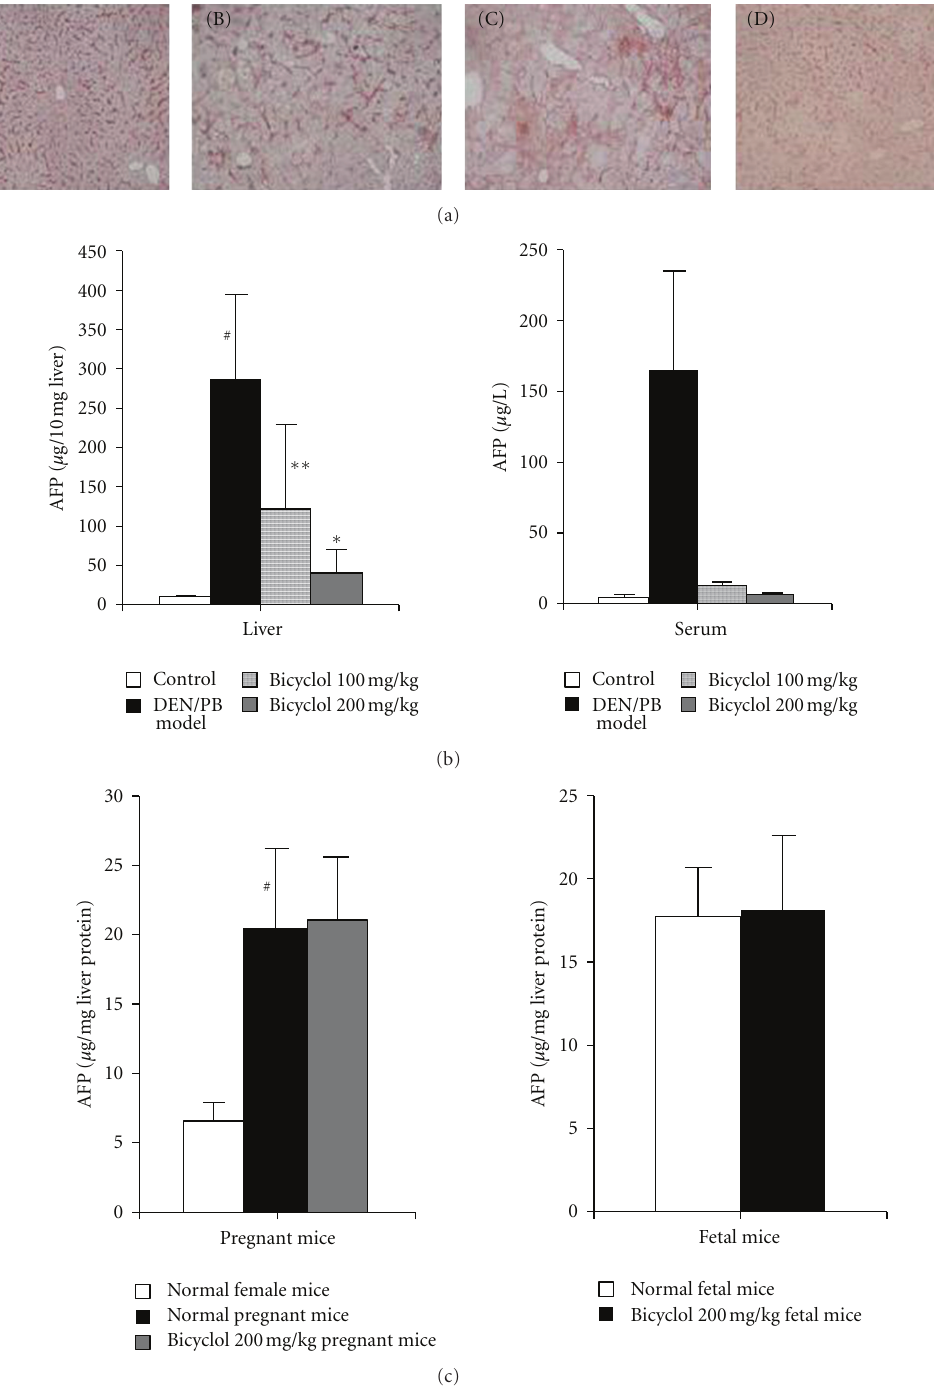
Figure 5: Expression and quantification of α -fetal protein (AFP). (a) AFP-immunoreactivity assay in the control and experimental groups at week 20 using immunohistochemistry assay. (A) control; (B) DEN/PB model; (C) treatment with bicyclol (100mg/kg) before DEN injection; (D) treatment with bicyclol (200mg/kg) before DEN injection. (b) Quantification of serum and tissue AFP levels in the control and experimental groups at week 20 using an enzyme immunoassay kit. Average values with standard deviations are shown. n = 8–10. # P < 0 . 05 compared with the control group; ∗ P < 0 . 05, ∗∗ P < 0 . 01 compared with the DEN/PB model group. (c) Quantification of liver AFP levels in pregnant mice and fetal mice using an enzyme immunoassay kit. Average values with standard deviations are shown. n = 4. # P < 0 . 05 compared with the control